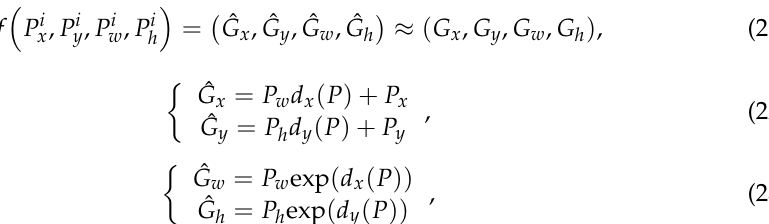
Figure 11. Concept map of CNN.